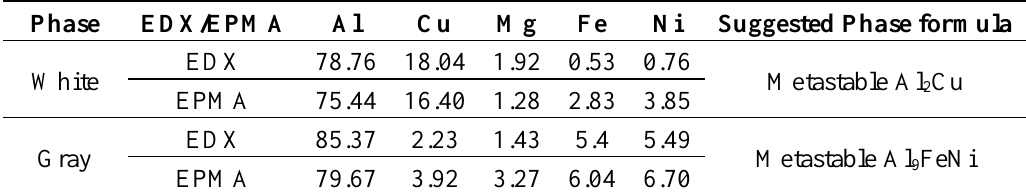
Table 4. The compositions of intermetallic compounds in Sample IC measured by EDX and EPMA (at%).